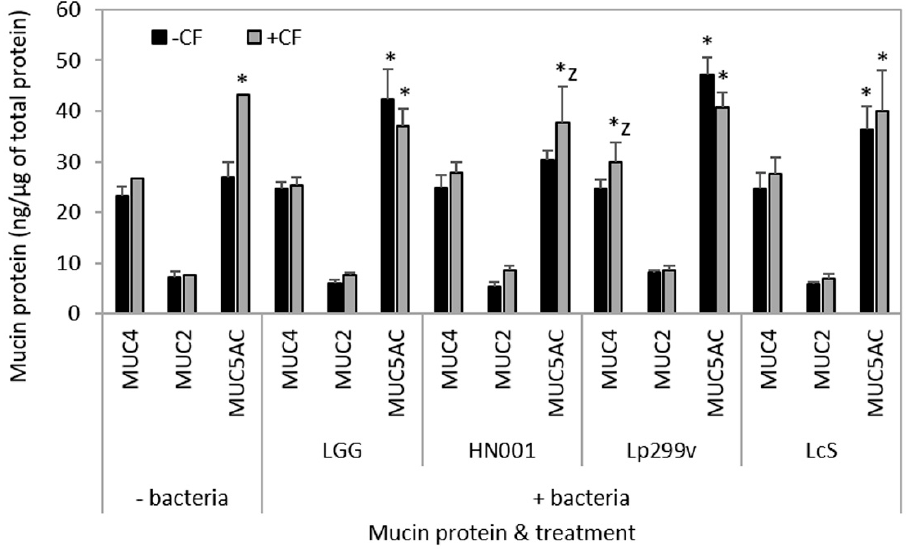
Figure 7. The abundance of MUC4, MUC2 and MUC5AC mucin protein from Caco-2:HT29–MTX (90:10) co-cultures after 3 h incubation with bacteria or a carbohydrate fraction (CF) from caprine milk either alone or in combination. Results are expressed as the mean abundance ( ± SEM); n = 3. * =significantly different ( P < 0.05) compared to untreated co-cultures, and z = significantly different ( P < 0.05) compared to co-cultures incubated with the respective bacteria only. UNT = untreated; LGG = L. rhamnosus GG; HN001 = L. rhamnosus HN001; Lp299v = L. plantarum 299v; and LcS = L. casei Shirota.